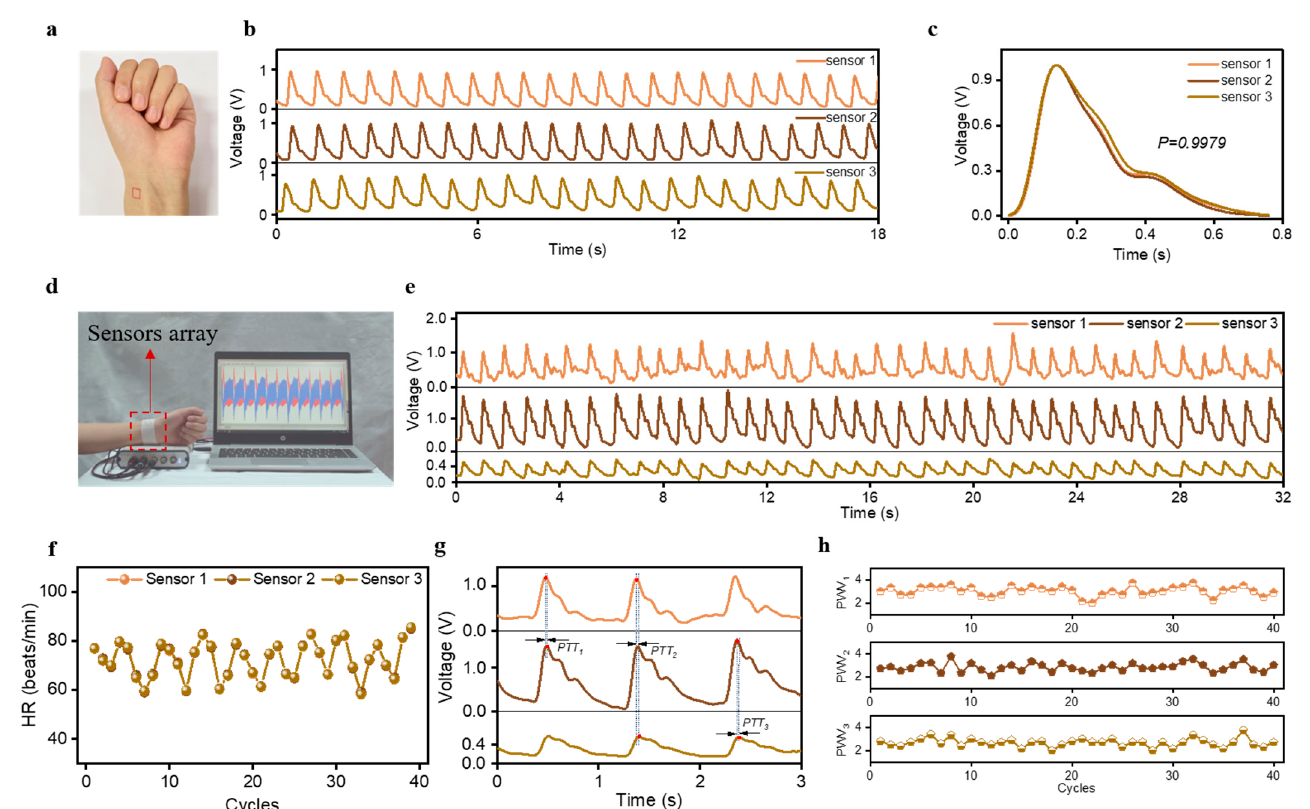
Figure 5. A flexible sensor array for monitoring pulse signals at multiple local positions of the wrist. ( a ) Pulse wave monitoring position indicated by marker. ( b ) The measured waveforms by the three sensors in sensor array at the same position. ( c ) The consistency of the signals measured by the three sensors. ( d ) The optical image of pulse wave monitoring by sensor array. ( e ) The measured pulse wave signals by sensor array. ( f ) Real-time HR value extracted from pulse signals obtained at three local locations. ( g ) The enlarged view of the pulse wave at three local locations and schematic of different PTTs. ( h ) The change trend of PWV value in 40 cycles.